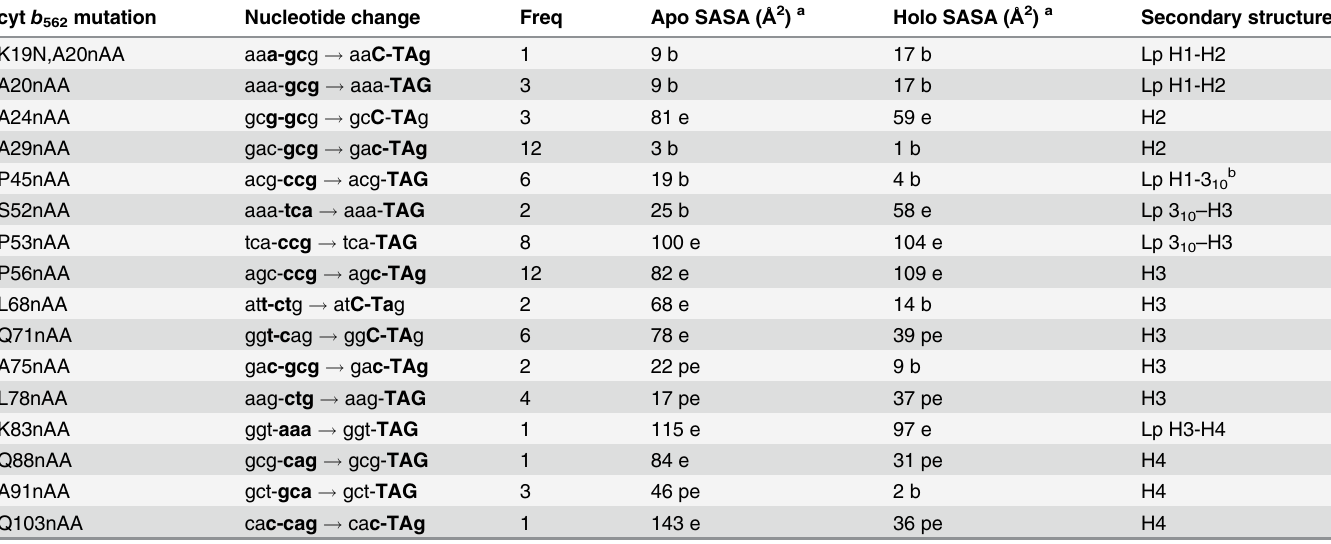
Table 1. Sequence and characteristics of observed cyt b 562 TAG replacement variants.